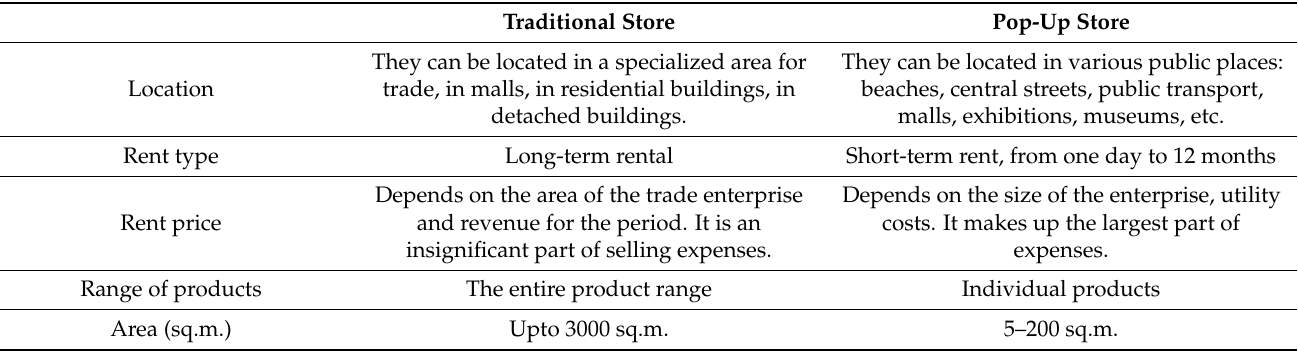
Table 2. Comparison of traditional and pop-up stores. Traditional